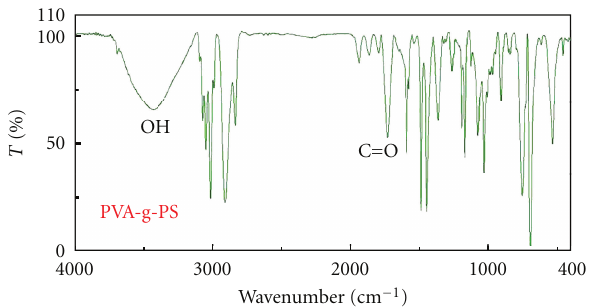
Figure 8: FTIR spectrums of PVA-g-PS.